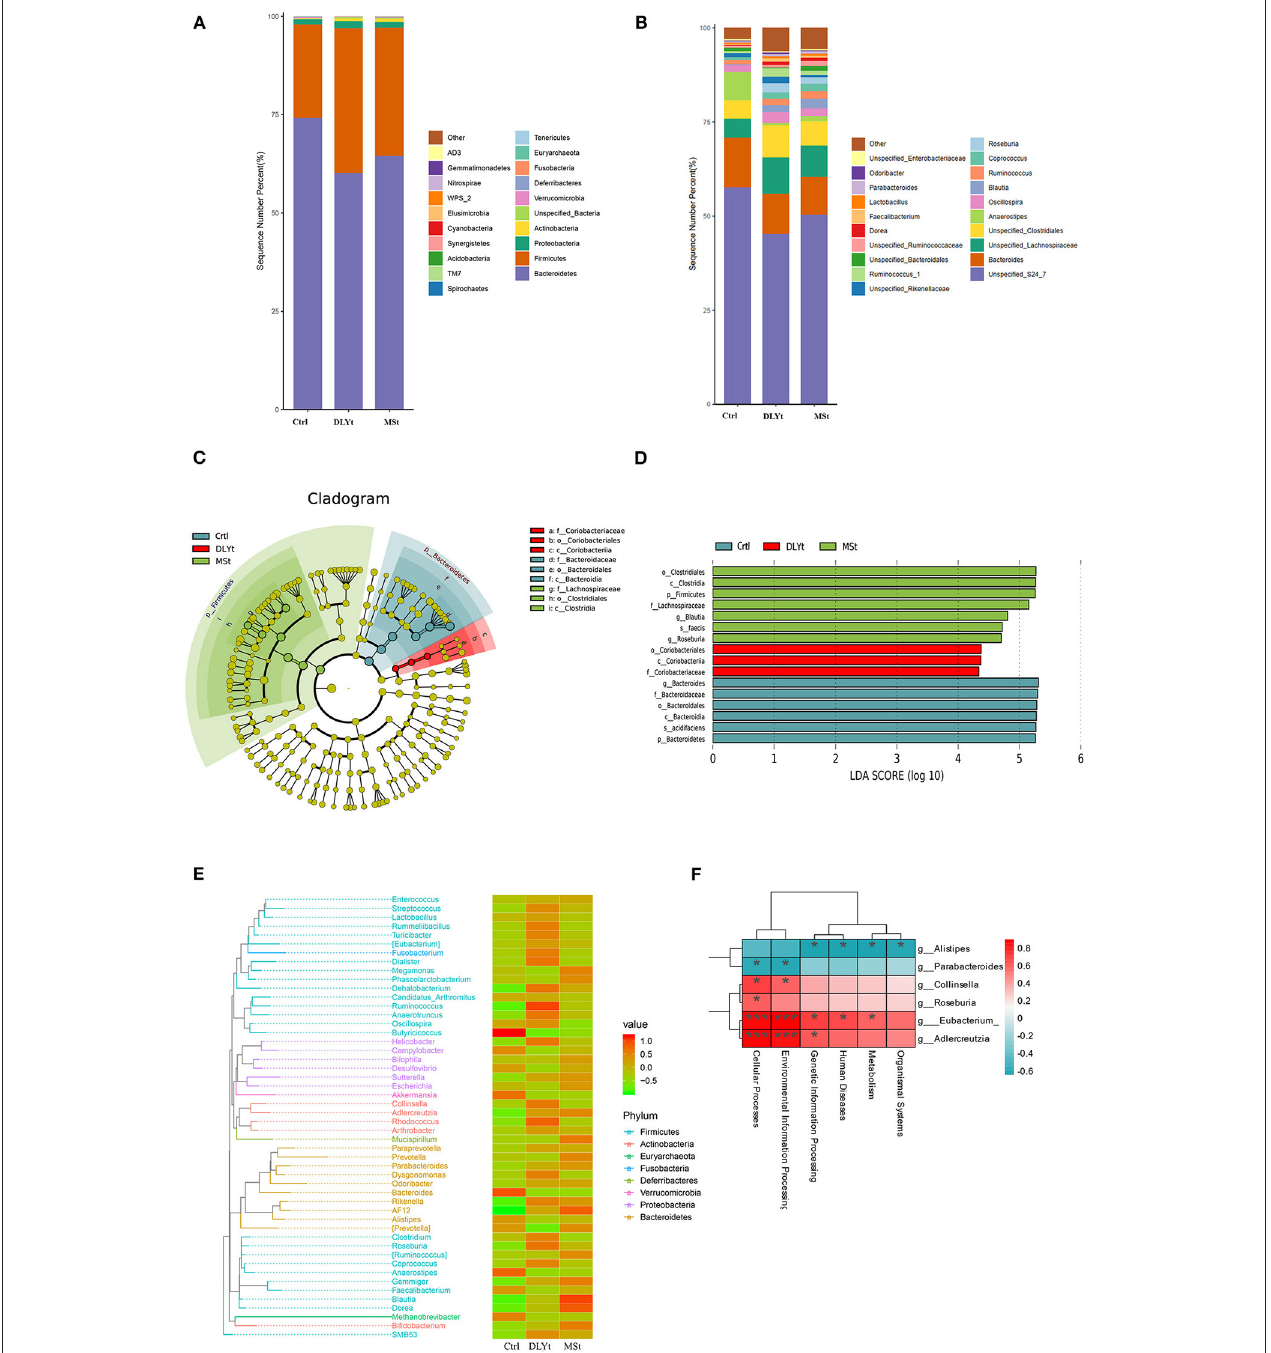
FIGURE 5 | FMT altered the composition of fecal microbiota. (A,B) Relative abundance at the phylum and family levels in fecal microbiota community of the three groups. (C) Cladogram representing the taxa enriched in fecal microbiota community of the four groups detected by the linear discriminant analysis effect size (LEfSe) tool. Differences were represented by the color of the most abundant class (red indicating the DLYt group, green indicating the MSt group, and yellow indicating nonsignificant). The diameter of each circle is proportional to the taxon’s abundance. (D) Differential bacterial taxonomy selected by LEfSe analysis with LDA score > 4 in the fecal microbiota community of the three groups. (E) Phylogenetic tree and heatmap of abundance distribution between the groups. The left figure shows the evolutionary tree, in which the branches of different colors represent different gates, each branch at the end represents an operational taxonomic unit (OTU), and the end is annotated with the genus classification to which the corresponding OTU belongs. In the absence of corresponding genus classification, it is expressed as unclassied_genus, the heatmap on the right is standardized after the abundance, and the larger the value, the higher the relative abundance. (F) Association analysis between intestinal microbiome. * means significant, *** means extremely